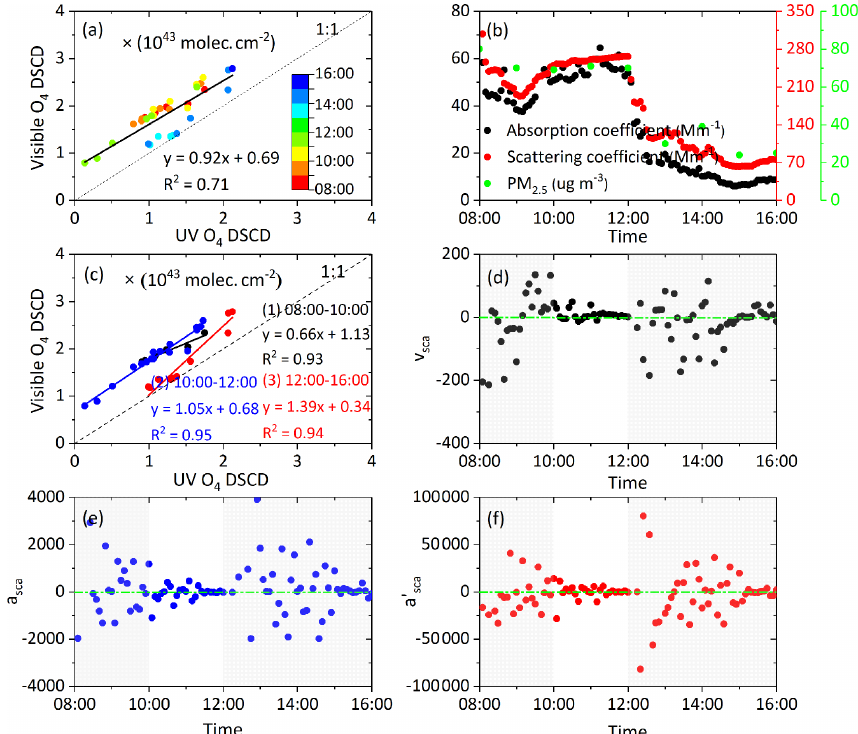
Figure 4. An example day on 21 February 2017: (a) the correlations between O 4 DSCDs at 360.8 and 477.1nm. The color bar represents time sequence. Panel (b) shows the time series of aerosol scattering and absorption coefficients. The correlation information between O 4 DSCDs at 360.8 and 477.1nm at 08:00–10:00, 10:00–12:00, and 12:00–16:00 on 21 February 2017 is shown in (c) . Panels (d) to (f) show the time series of v sca , a sca , and a (cid:48) sca of scattering coefficients,